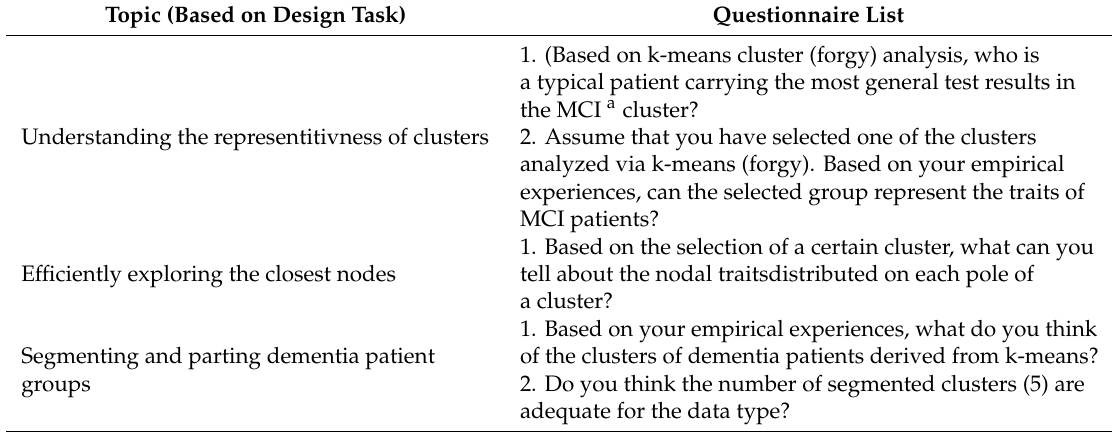
Table 3. Participant questionnaire for qualitative